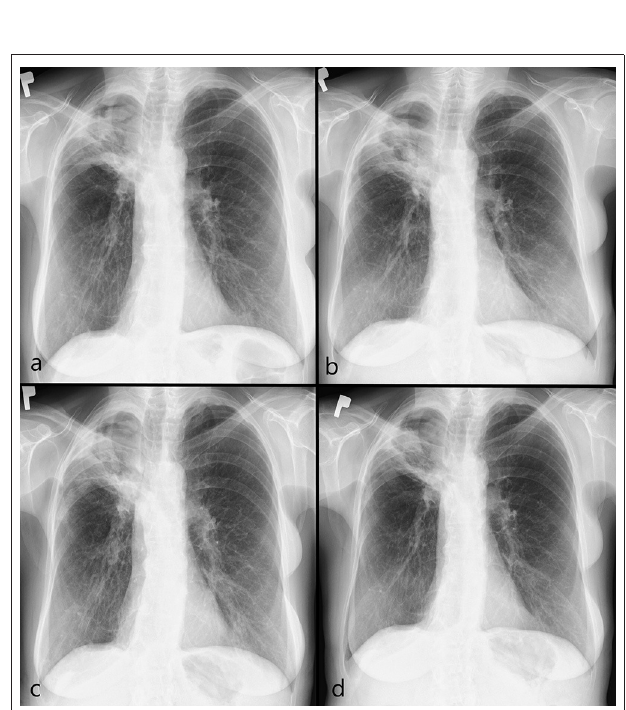
FIGURE 4 | Controlled chest x-ray during first-line treatment in 2020: (a) at the beginning of the therapy – thick-walled cavity with internal consolidations in apical parts of the right lung; (b) after 2 months – cavity consolidation; (c) after 4 months – further cavity consolidation; (d) after 6 months – image